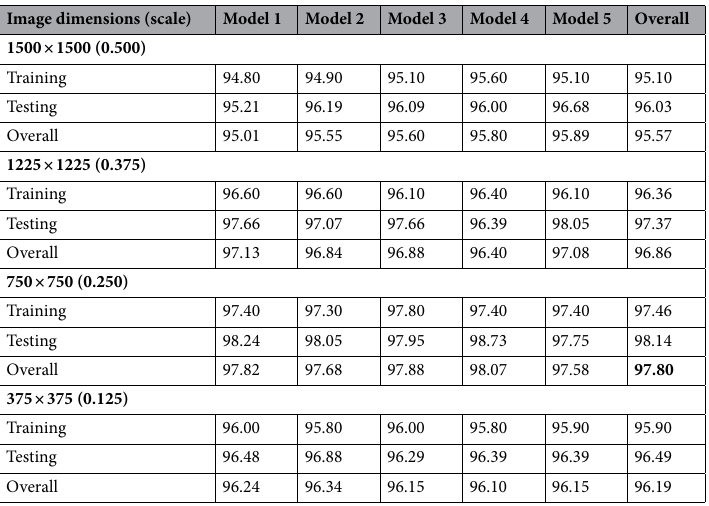
Table 3. Classification accuracies for static signs at 500 bags. Significant values are in bold.